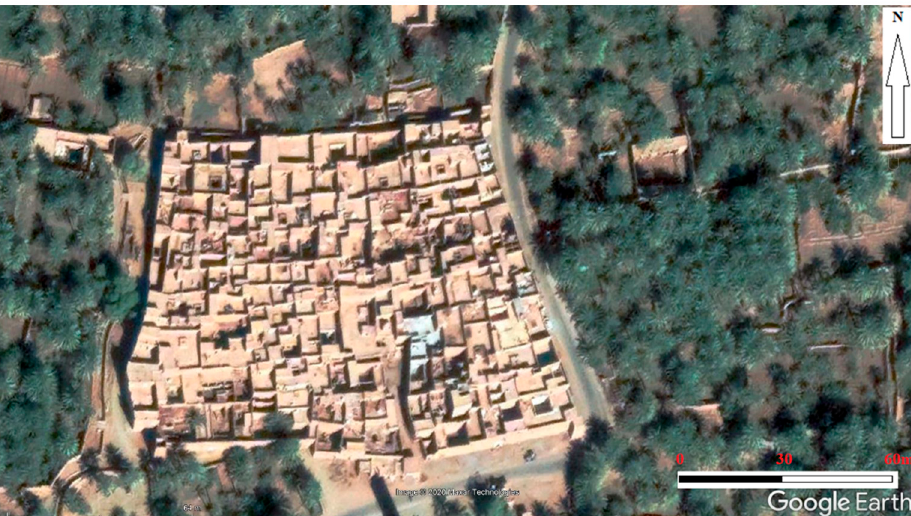
Figure 17. The village of Mansouria from Google Earth.